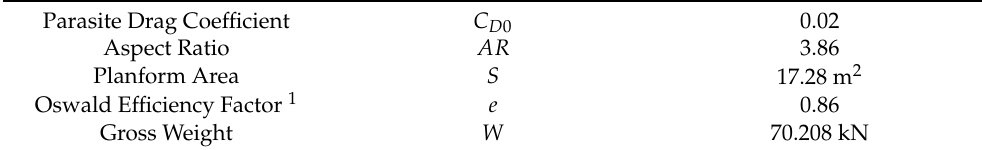
Table 1. Northrop F-5E Tiger II